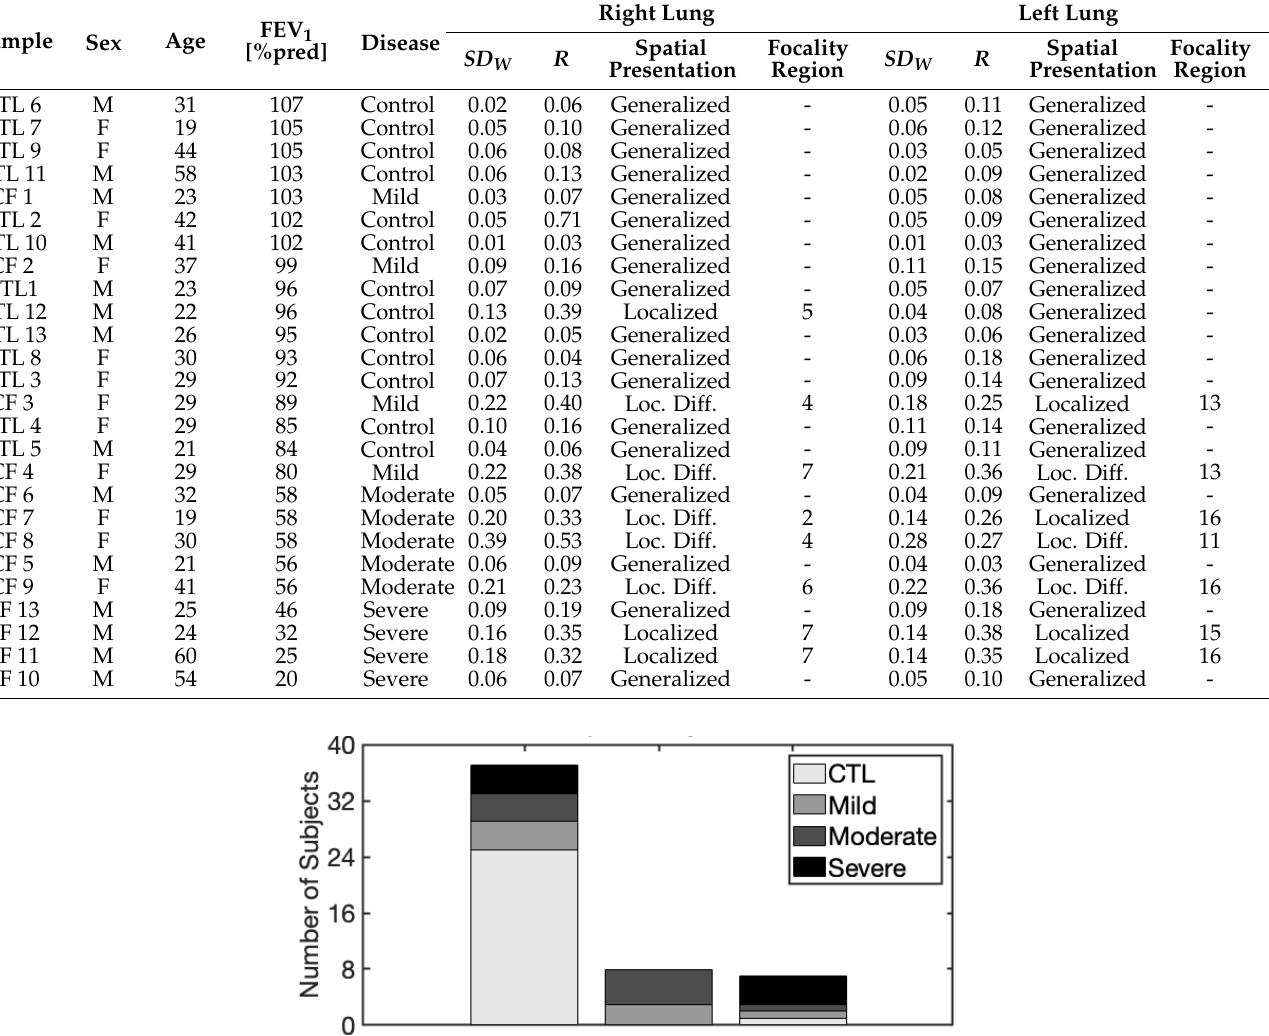
Table 3. Subject demographics, FEV 1 , and spatial presentation assignments. Category of spatial presentation and focality region, when applicable, for each subject.